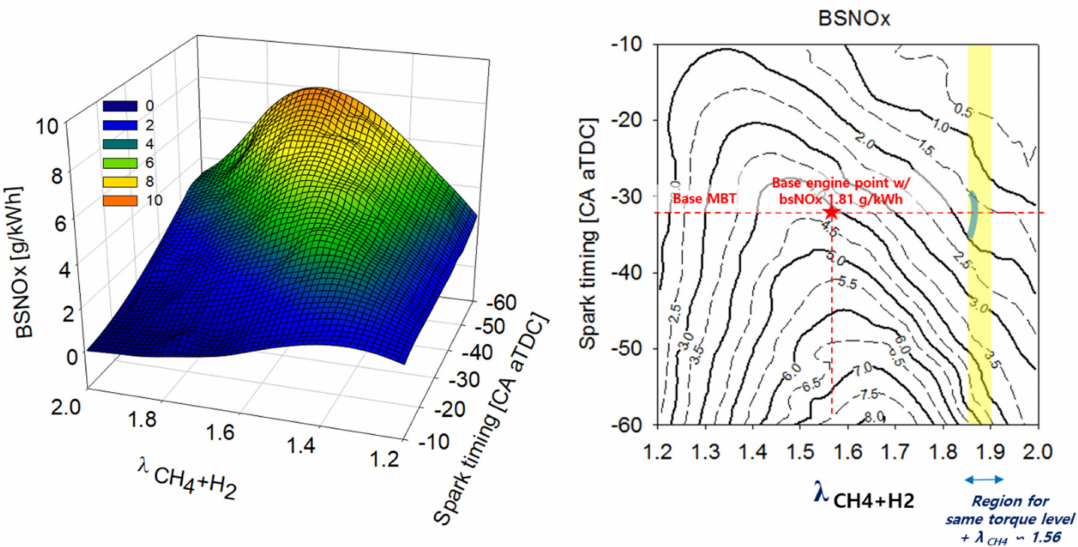
Figure 13. Response surface model: brake specific NOx as functions of spark timing and hydrogen added methane based EAR @1500